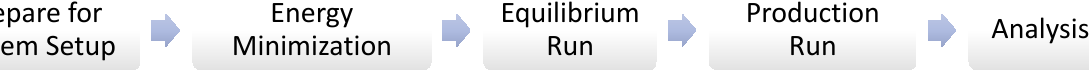
Figure 35. The MDS procedure.